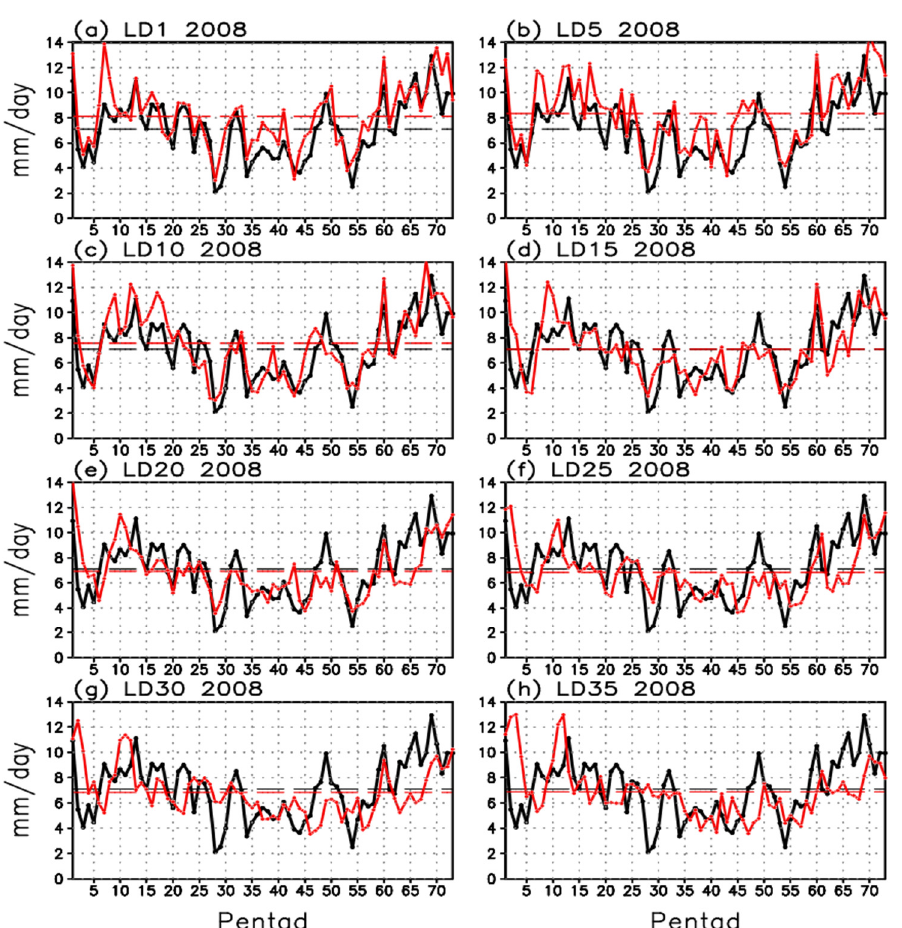
Figure 15. Same as in Figure 14, but for 2008. ( a ) LD1; ( b ) LD5; ( c ) LD10; ( d ) LD15; ( e ) LD20; ( f ) LD25; ( g ) LD30; and ( h ) LD35.